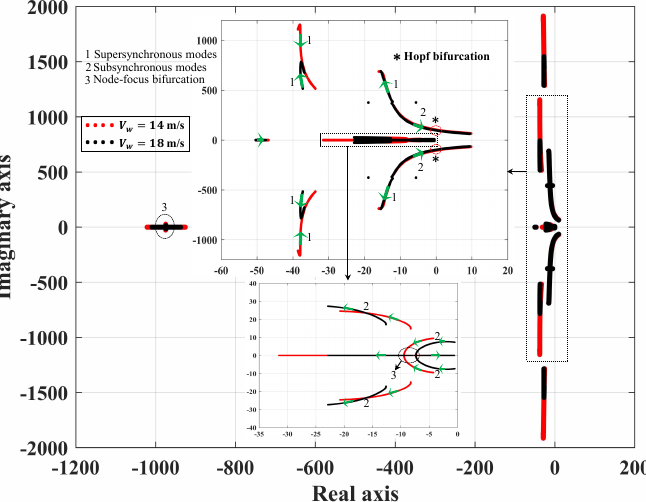
Figure 7. Eigenvalues with SVC for low and high wind